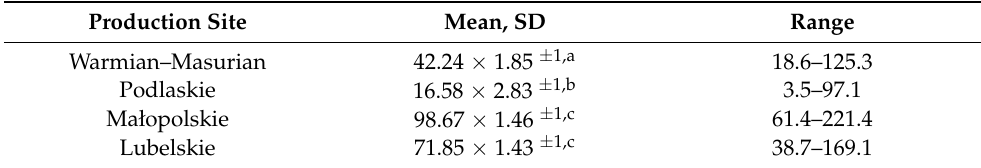
Table 1. 210 Po activity concentration (mBq/L) in fruit wine samples derived from different locations in